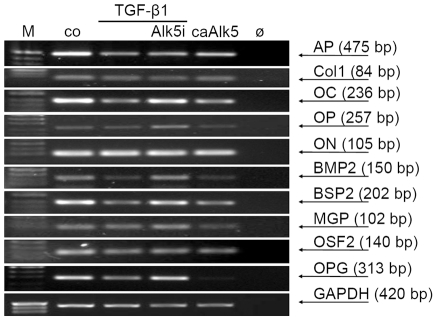
TGF-β1 regulates expression of osteoblast marker genes.Primary human osteoblasts (N = 4), stimulated for 8 days with 5 ng/ml hr TGF-β1 with or without 20 nM SB431542 or infected with Ad5-caAlk5 virus particles, were investigated for expression of osteogenic marker genes by RT-PCR. alkaline phosphatase (AP), collagen1 (Col1), osteocalcin (OC), osteopontin (OP), osteonectin (ON), BMP2, bone sialoprotein (BSP) 2, matrix gla protein (MGP), osteoblasts specific factor (OSF) 2 and osteoprotegerin (OPG). GAPDH was used as housekeeping gene. Ø negative control (H2O) Corresponding densitometric analysis is summarized in Table 2.